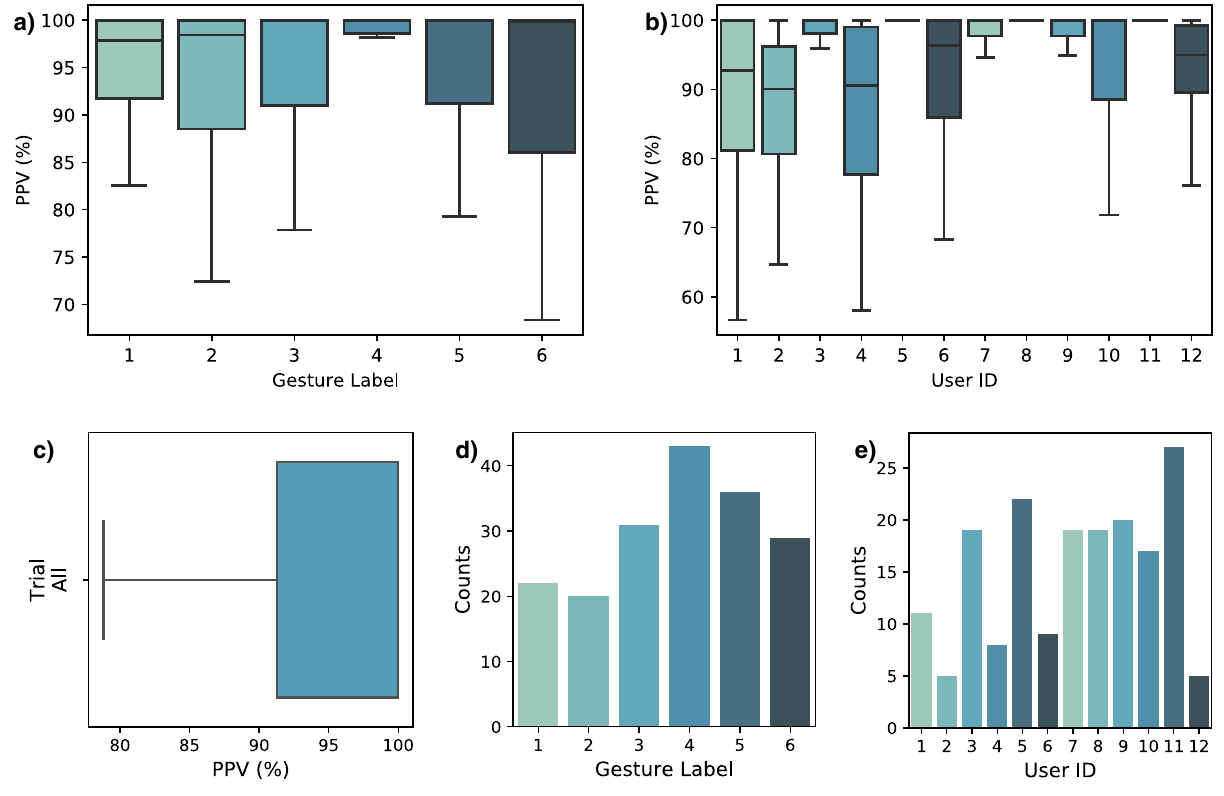
Figure 5. Real-time accuracy results. ( a ) Real-time trials evaluation results shown per gesture label and ( b ) per user. ( c ) Results of all trials across all participants shown on a box plot. The median positive predictive value (PPV) is 100%. The mean PPV is 93.43%. ( d ) Counts of perfect trials (100% PPV) per gesture and ( e ) per